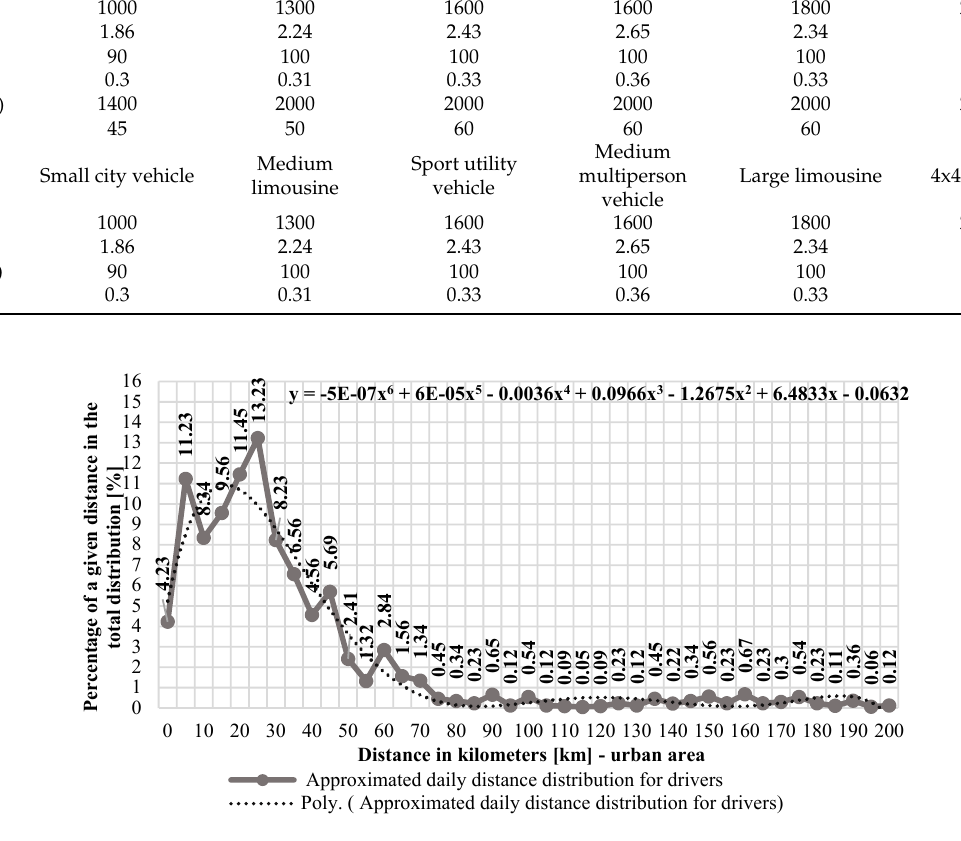
Figure 2. Monthly distance distribution for ICEVs, PHEVs, and BEVs operated in urban mode— approximate value based on experimental tests.